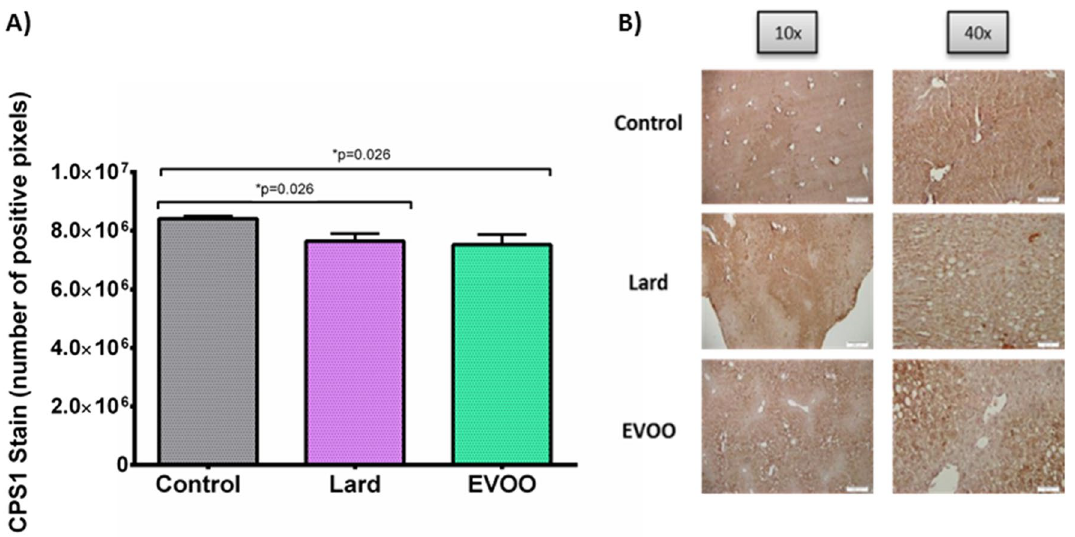
Figure 5. CPS1 findings in LDLr −/− animals. ( A ) represents the number of positive pixels quantified by ImageJ and ( B ) shows the staining. CPS1: carbamoyl phosphate synthetase-1; EVOO: extra virgin olive